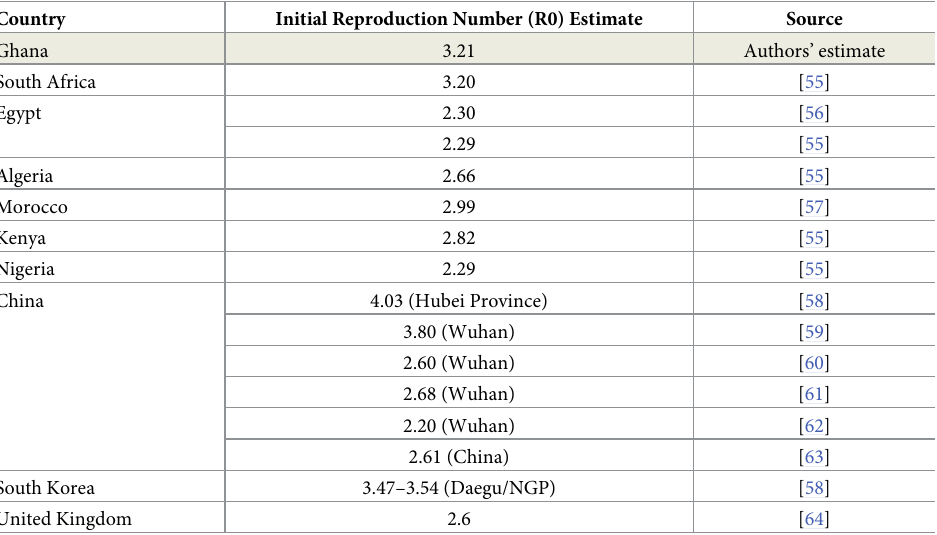
Table 2. Estimates of R 0 and comparison to other country